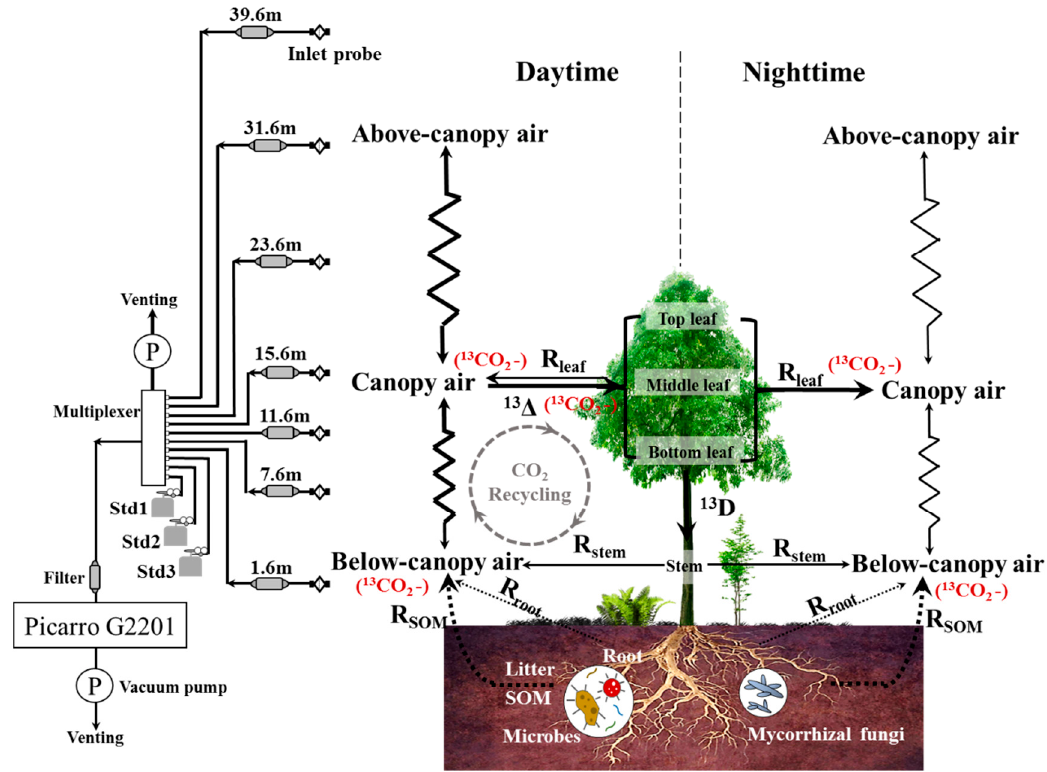
Figure 1. The processes contributing to forest CO 2 and its stable carbon isotope ( δ 13 C), and the multi-inlet profile system used to sample CO 2 and its δ 13 C in and above the canopy. 13 Δ represents photosynthetic carbon isotope discrimination, R represents the respiration of different components, and 13 D represents the carbon isotopic disequilibrium between ecosystem photosynthesis and respiration. SOM represents soil organic matter. The gray dashed lines represent the recycling of respired ecosystem CO 2 by photosynthesis, black broken lines represent turbulent mixing, and black dotted lines represent the CO 2 diffusion of soil respiration ignoring chemoautotrophic and anaplerotic fixation. Std1, Std2, and Std3 represent three standard gases of the profile system. Picarro G2201 represents the Picarro G2201-i CO 2 δ 13 C analyzer (Picarro Inc., Sunnyvale, CA, USA).